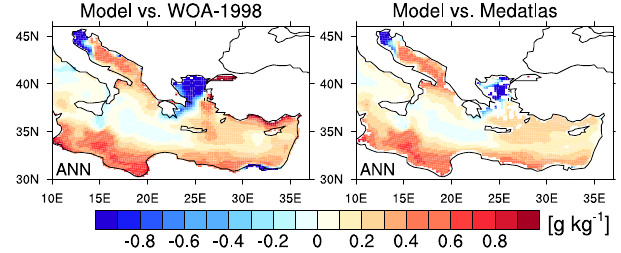
Fig. 6. Annual mean SSS deviations at 6m depth. CTRL vs. World Ocean Atlas 1998 climatology (left) and CTRL vs. MEDATLAS climatology (right) are